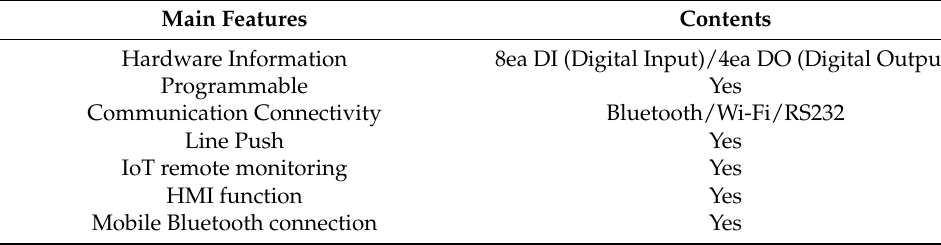
Table 1. Controller System Functions.